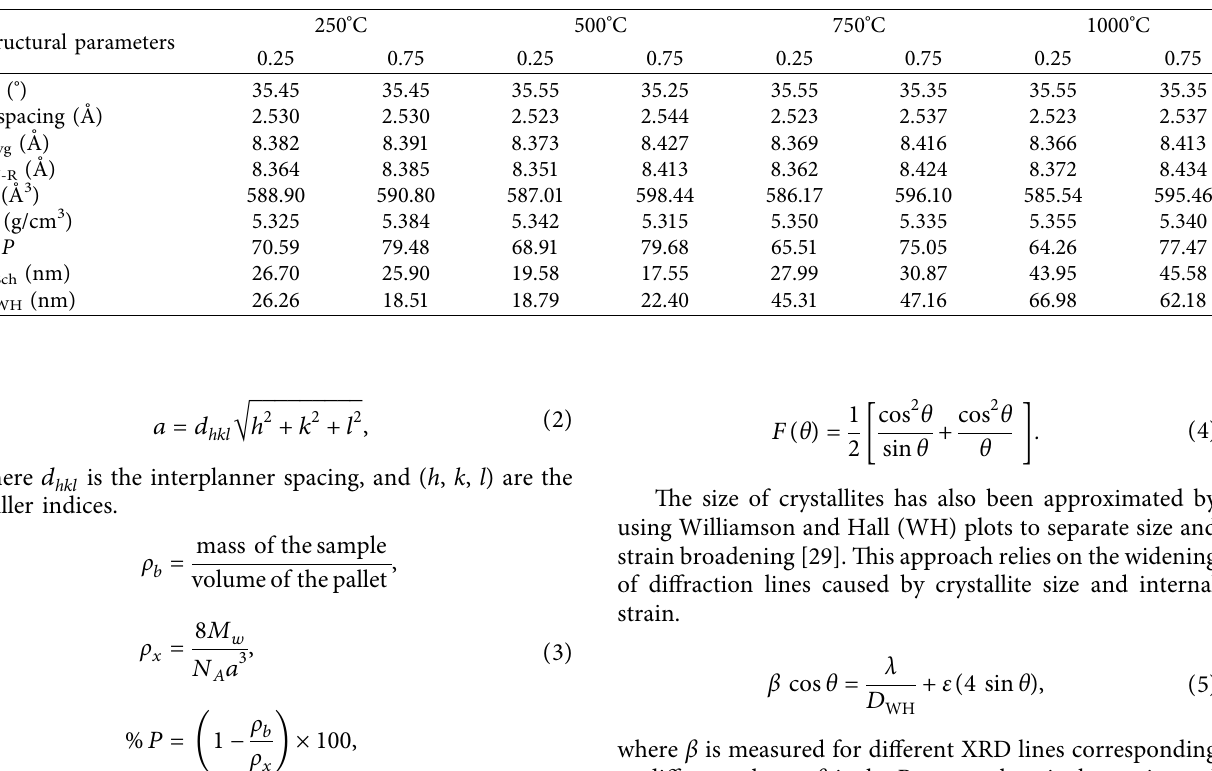
Figure 2: X-ray diffraction patterns of synthesized: (a) Ni 0.75 Zn 0.25 Fe 2 O 4 and (b) Ni 0.25 Zn 0.75 Fe 2 O 4 at different annealing temperatures. Table 1: 2Theta for maximum intensity, 2 θ , d -spacing, d , average lattice parameter, a avg , lattice parameter from NR plot, a NR , unit cell volume, V , crystal sizes from Scherrer’s method, D Sch , crystal size from WH plot, D WH , X-ray density, ρ x (g/cm 3 ), and porosity, % P , of the samples at different annealing